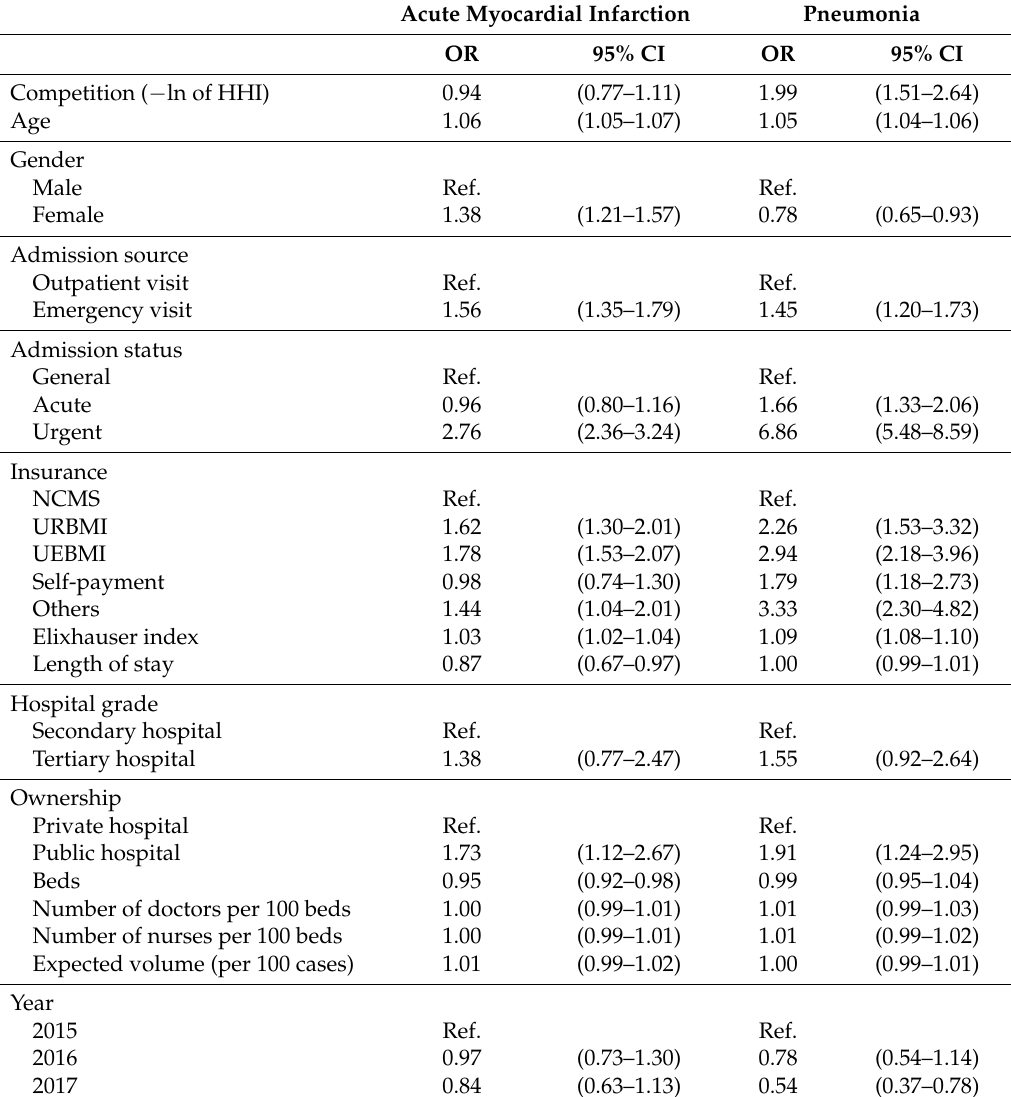
Table 2. Random-intercept logistic regression: estimates of hospital competition effect on